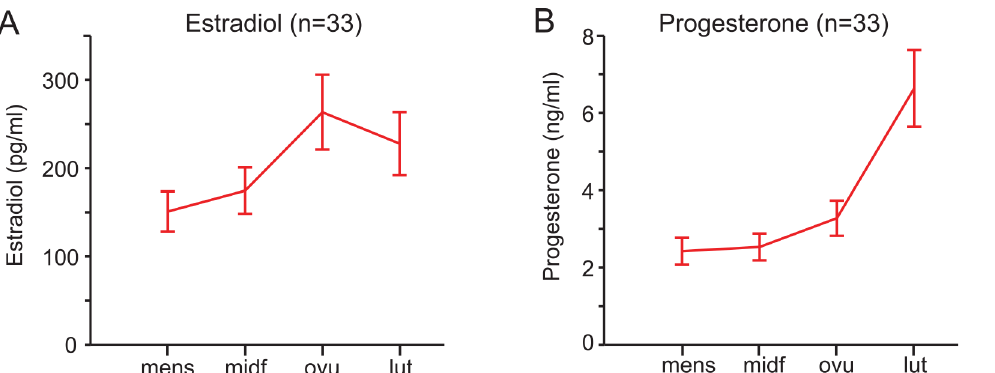
Fig 3. Hormone levels in the subject population. (A) Average estradiol levels in 33 subjects, all with blood samples in all four phases. Differences between adjacent phases are significant at p < 0.01 except between ovulation and the luteal phase (p = 0.063). (B) Average progesterone levels. All differences between adjacent phases are significant at p < 0.01 except between menses and the mid-follicular phase (p = 0.52) and between the mid-follicular phase and ovulation (p = 0.077).